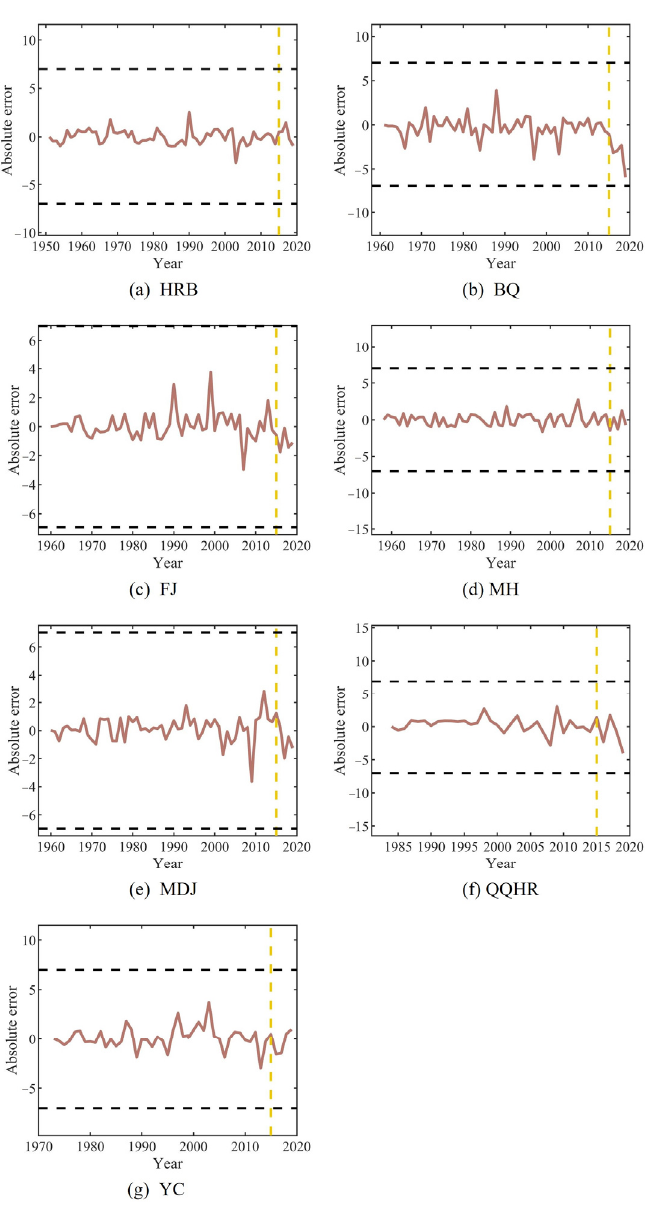
Figure 5. The absolute error ( AE ) of the simulation results of CEEMDAN-LSTM at each station in Heilongjiang Province (the black dashed line represents the maximum allowable error stipulated by the standard for hydrological information and hydrological forecasting, and the yellow dashed line divides the training period and the forecast period). Table 6. The absolute error range, MAE, and QR of CEEMDAN-LSTM at each